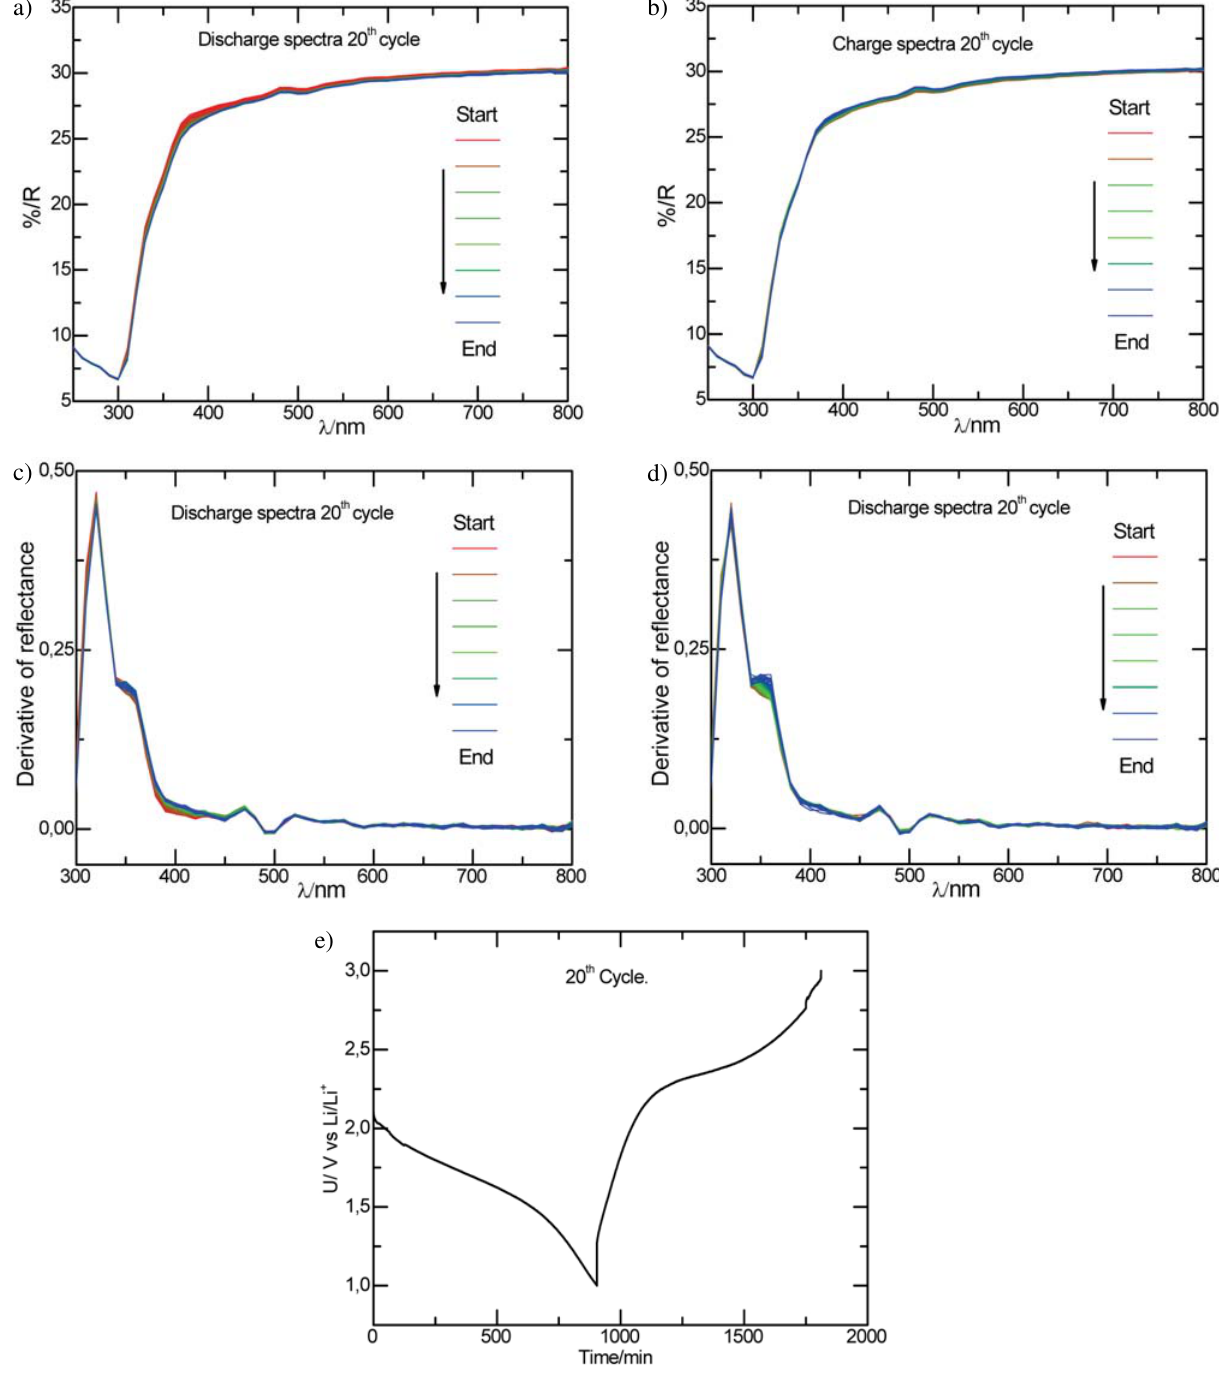
Figure 6. a, b) Obtained UV-Vis spectra from discharge and charge cycle of PAN/S composite on the 20 th cycle. c, d) The first derivative of the ob- tained spectra during discharge and charge cycle showing shifts in the wavelength. e) The 20 th cycle electrochemical curve of in-situ UV-VIS mea- surement of PAN/S